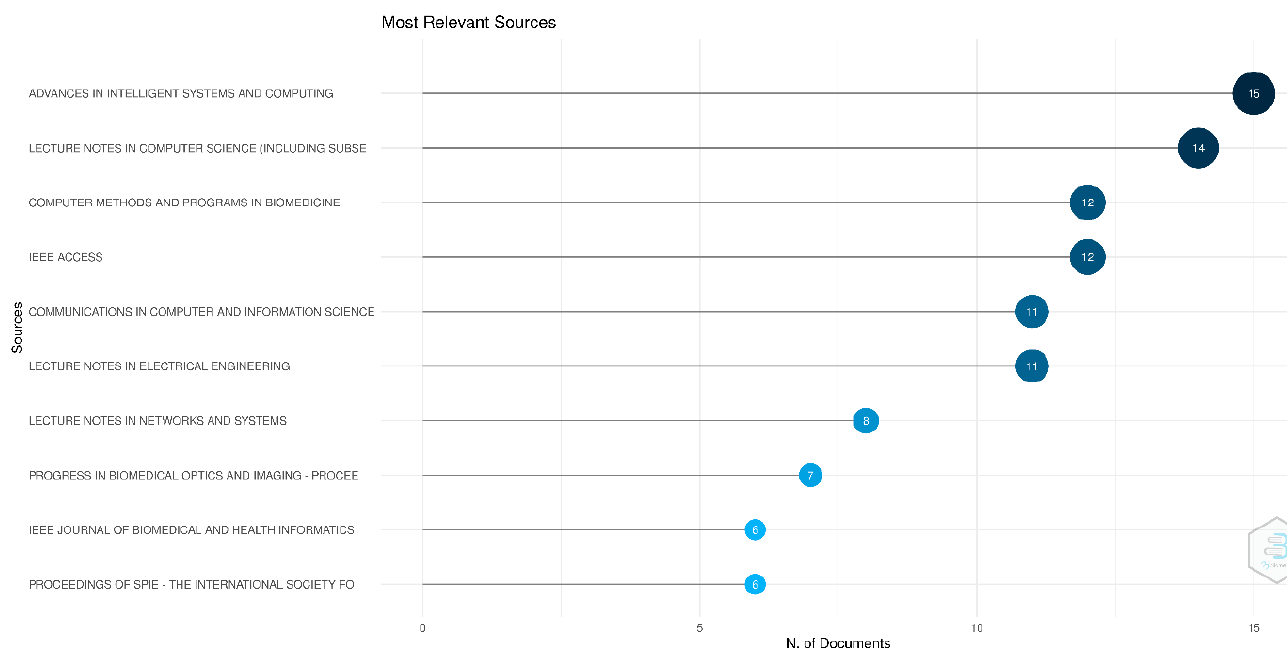
Figure 12. Top 10 most relevant sources.